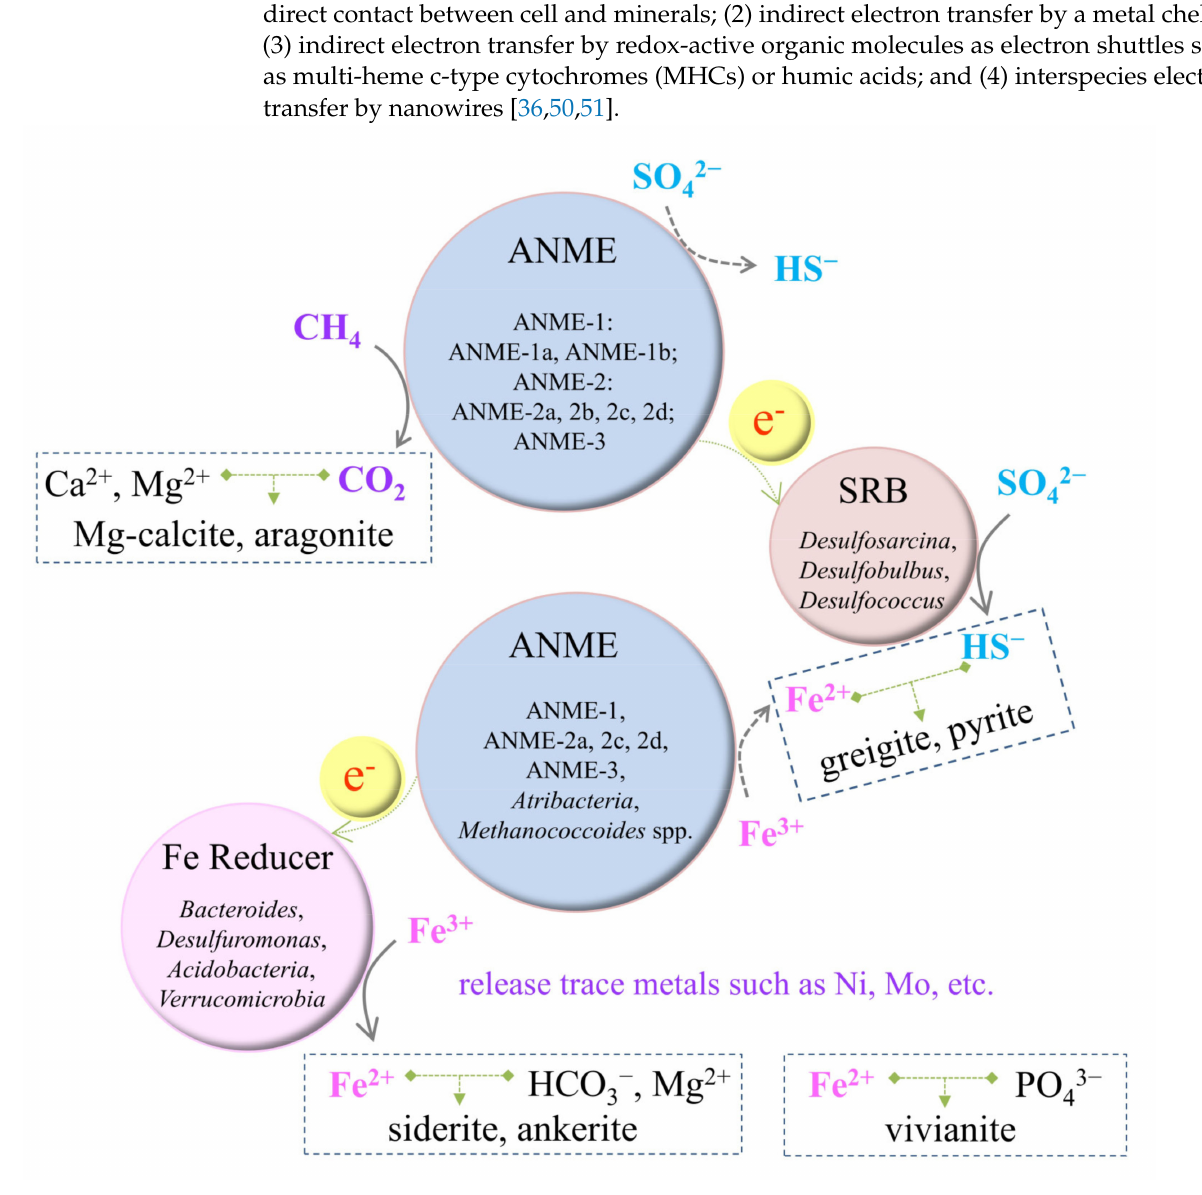
Figure 2. Possible interpretations for the biogeochemical process of Fe-AOM in